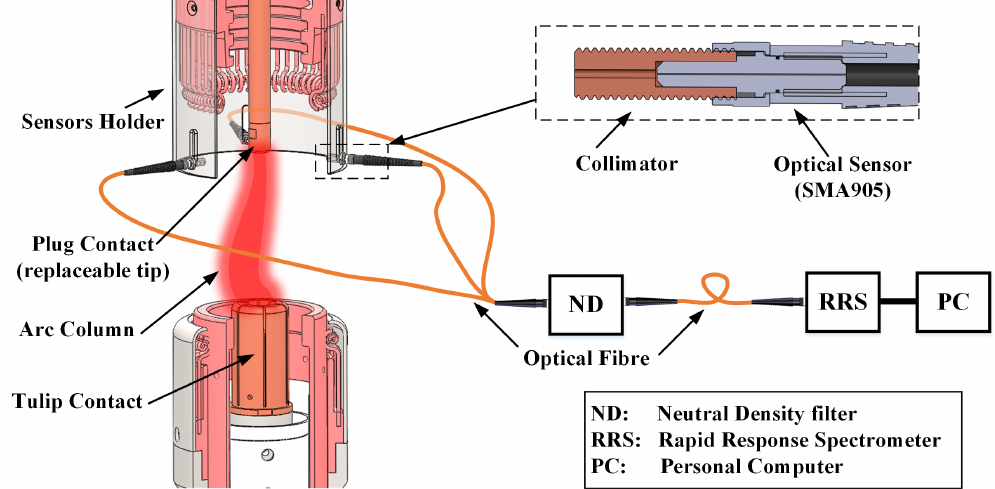
Figure 1. Schematic diagram of interrupter and optical measurement